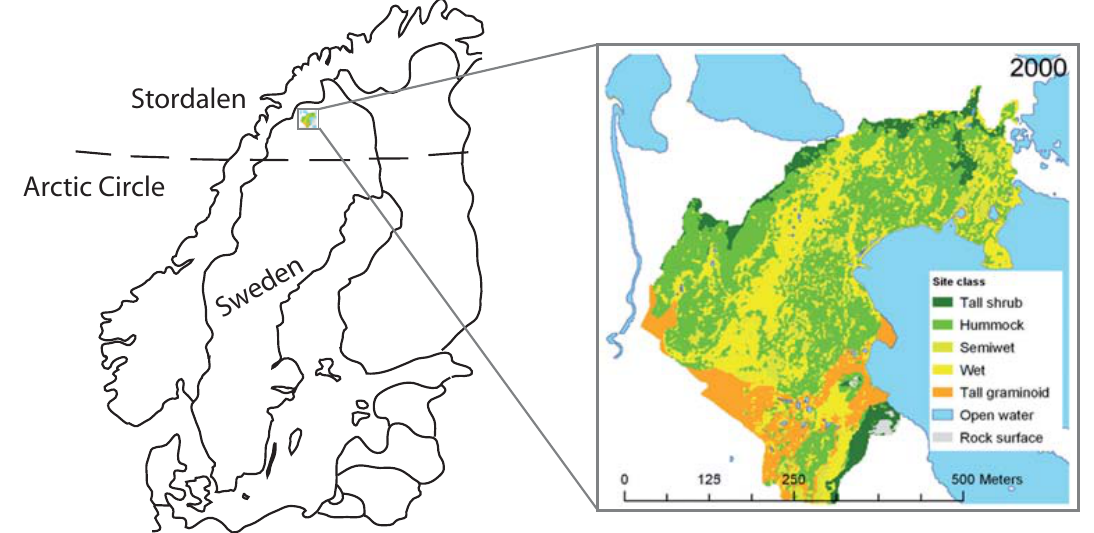
Fig. 1. Location map showing the position of the Stordalen mire in Northern Sweden (68 ◦ 22 0 N, 19 ◦ 03 0 E) and also a vegetation map illustrating the highly variable plant community distribution at the mire (from Malmer et al., 2005). The Hummock class in the vegetation map corresponds to the Palsa site in this study, whereas the Semiwet and Wet classes corresponds to Sphagnum site and Tall graminoid class corresponds to Eriophorum